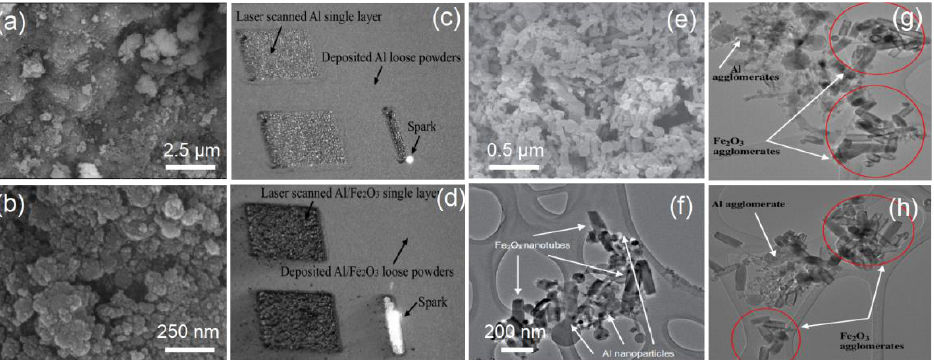
Figure 2. Field emission scanning electron microscopy (FESEM) image ( a , b ) of Al/Fe 2 O 3 nEMs by soft template self-assembly with sol-gel process [46] Copyright 2015, Journal of Solid State Chemistry, a comparative visual observation of laser melting method process on a thick layer of ( c ) Al powder and ( d ) Al/5 wt% Fe 2 O 3 powder mixture [47] Copyright 2012, Advanced Engineering Materials, the ( e ) FESEM and ( f ) transmission electron microscope (TEM) image of self-assembled Al/Fe 2 O 3 nEMs, and followed by the ( g ) and ( h ) TEM images of physically solvent-mixed Fe 2 O 3 nanotubes-Al nanoparticles sample [48] Copyright 2010, Combustion and Flame.